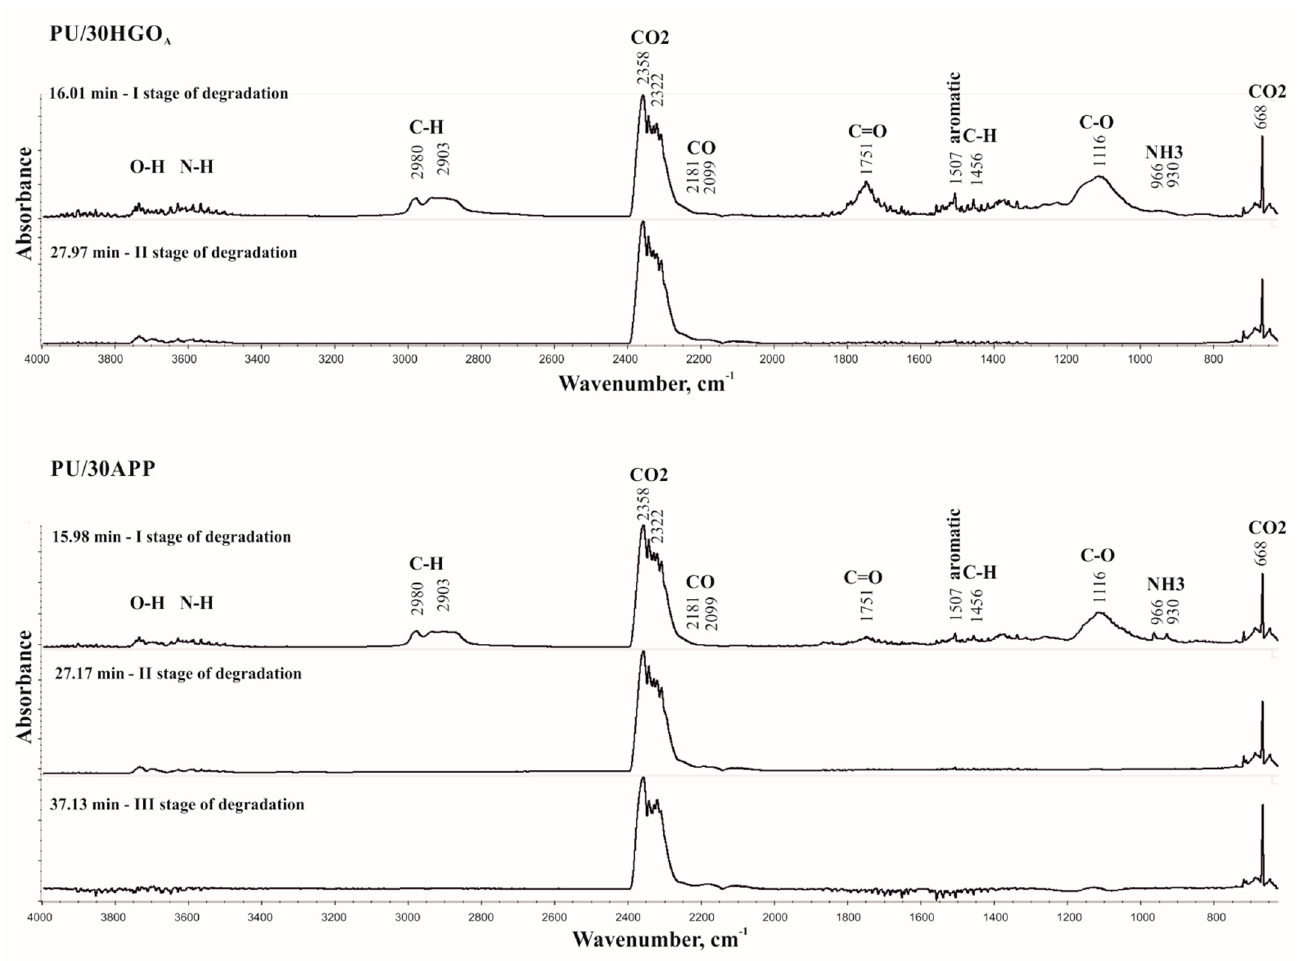
Figure 14. The 3D TGA/FT-IR spectra of PU/30HGO A and PU/30APP.